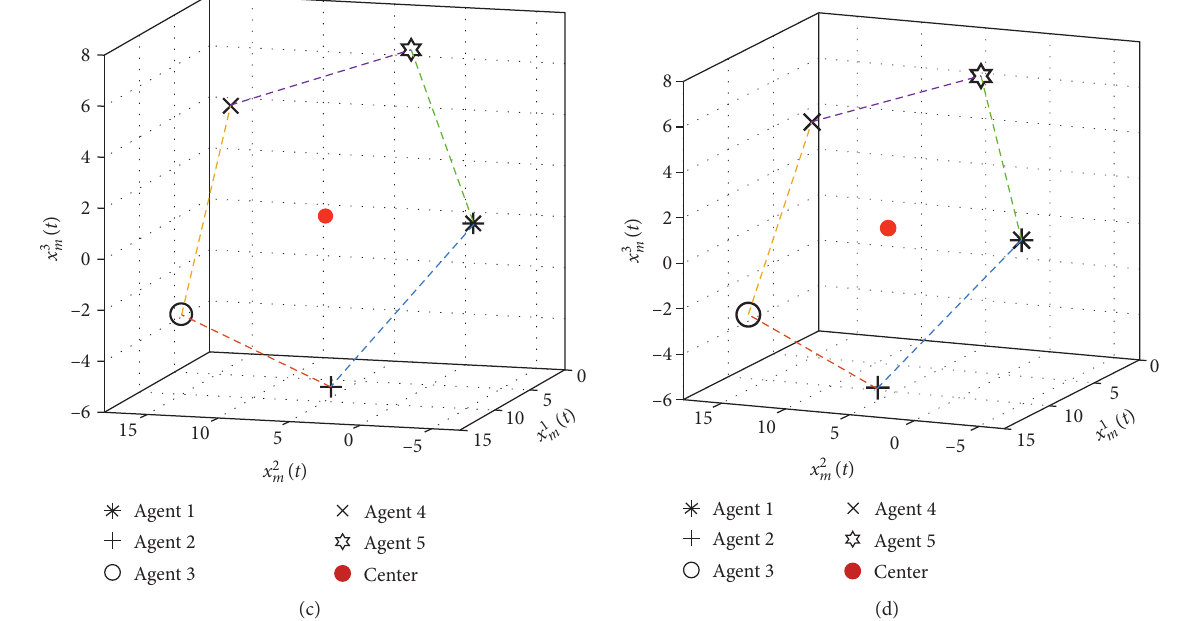
Figure 5: State snapshots for dynamic whole motion. (a) t � 0s. (b) t � 14s. (c) t � 16s. (d) t � 18